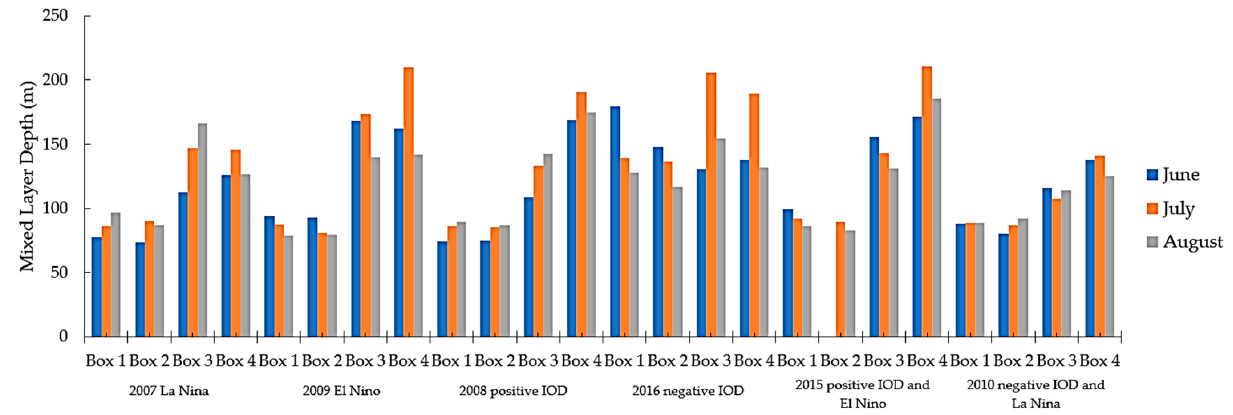
Figure 20. The average mixed layer depth in all boxes. Table 3. Correlation between monthly averages of SST, ONI, and DMI in all boxes from 2007 to 2020. SST Anomalies Box 1 Box